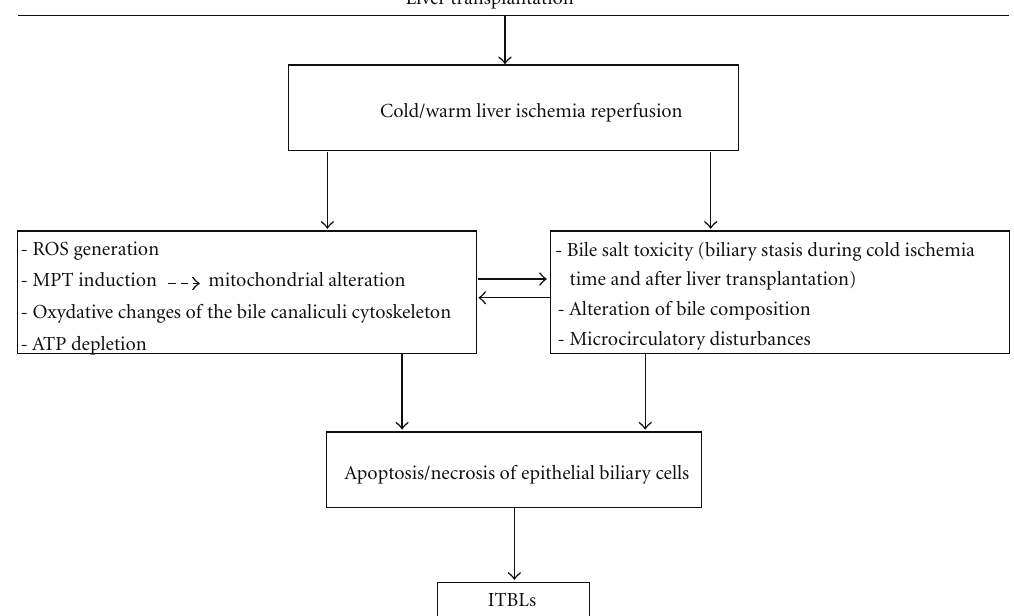
Figure 1: Cold and warm liver I-R leading to ITBLs following LT. ROS: reactive oxygen species; MPT: mitochondrial permeability transition; ATP: adenosine